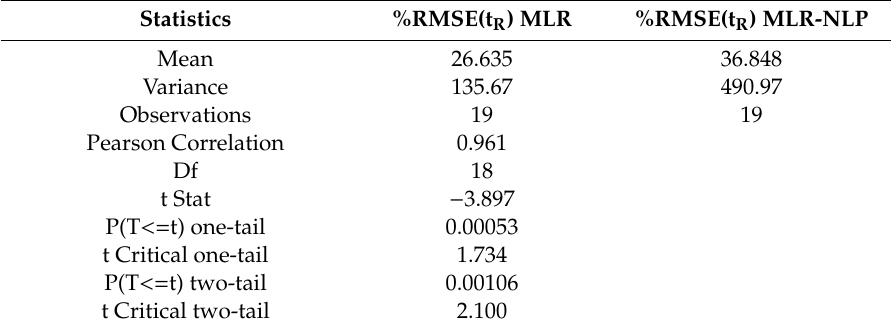
Table 1. Summary of the paired t -test for all the QSRR model performances for all the columns between the two approaches (MLR and MLR-NLP).